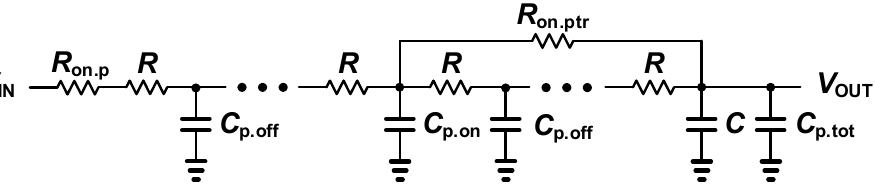
Figure 4. RC network model of proposed delay cell.